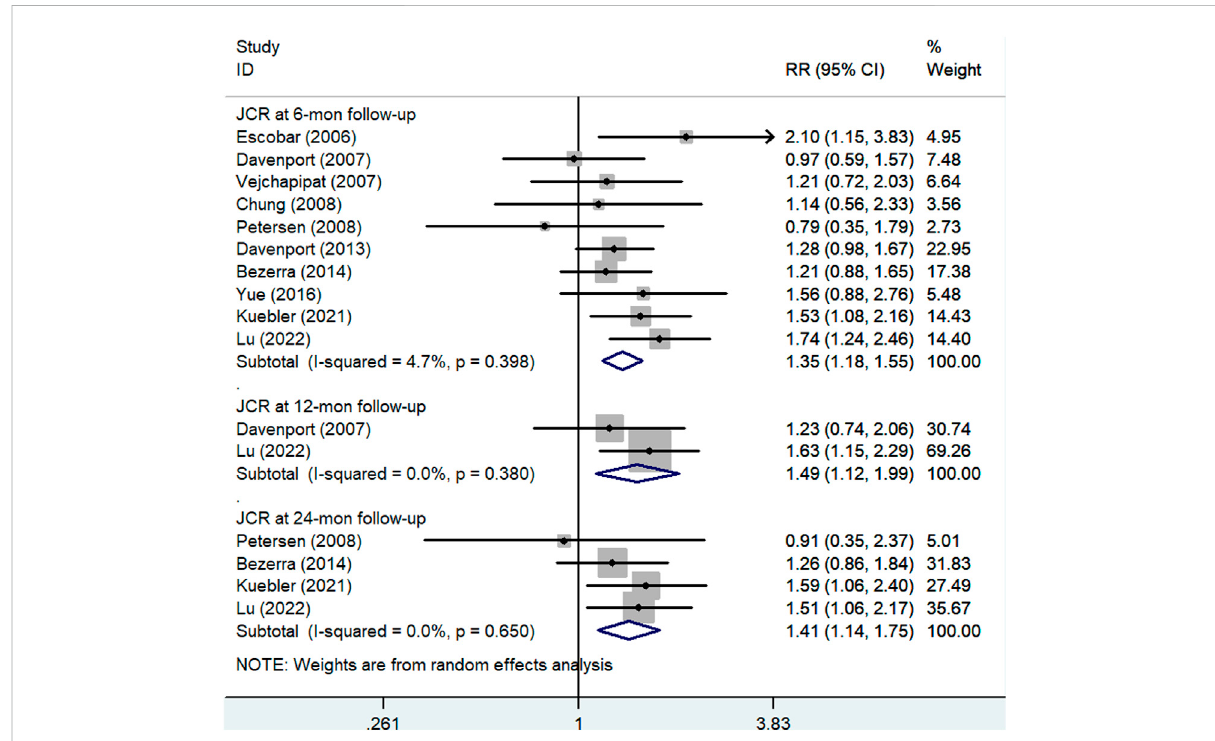
FIGURE 3 Forest plot for JCR at 6, 12, and 24 months of steroid vs. non-steroid group. JCR, jaundice clearance